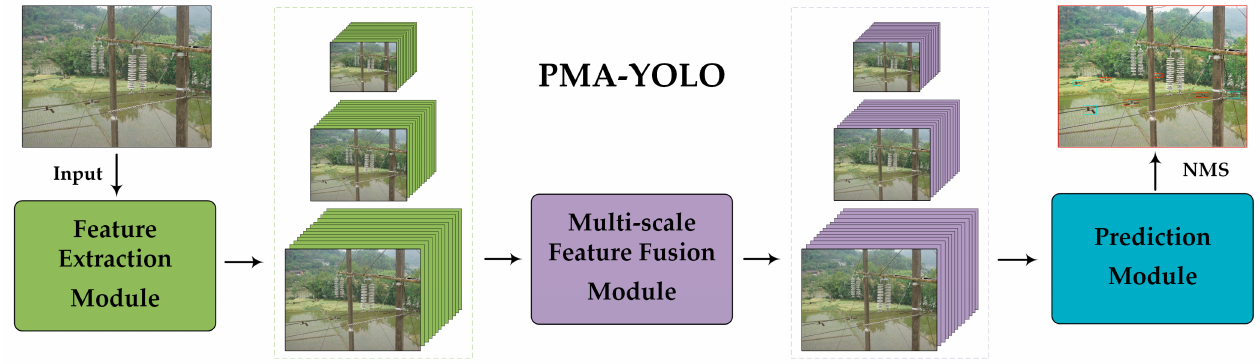
Figure 9. Overall architecture of the PMA-YOLO